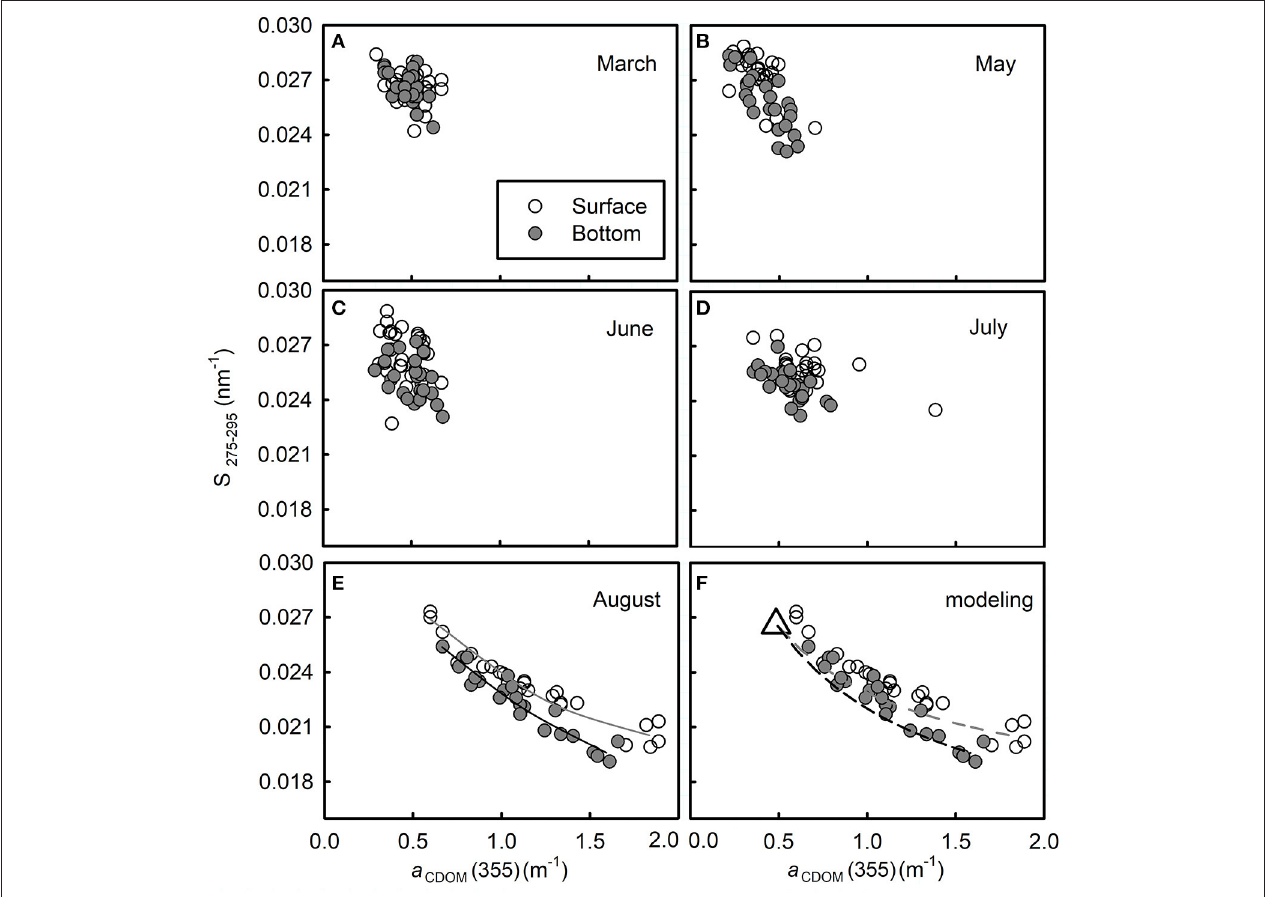
FIGURE 7 | Plots of S 275 − 295 vs. a CDOM (355) from March to August in 2016 ( A–E , respectively). In panel (E) , the solid line in dark gray is the best fit of the surface data [ y = − 0.0127log( x ) + 0.0239, R 2 = 0.943]; solid line in black is the best fit of the bottom data [ y = − 0.0159log( x ) + 0.0228, R 2 = 0.910]. Panel (F) is the modeling result of two-end member conservative mixing in August . The dashed line in gray shows the modeled curve in the surface layer and the black one shows that in the bottom layer. The remaining refractory CDOM pool is defined as one end-member (assuming that it equals to the average of data in March, shown as an open triangle); the fresh CDOM pool in the surface (or bottom) layer in August is defined as another end-member [derived from the four water samples with the highest a CDOM (355) in each